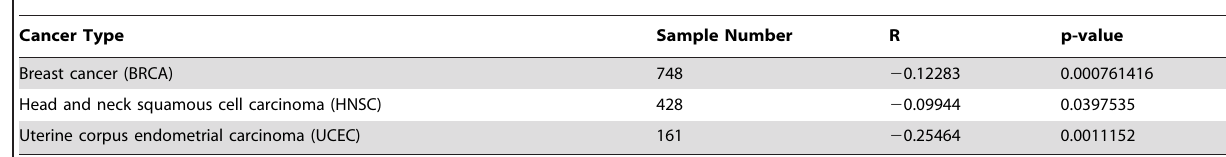
Table 3. Elk3:hsa-miR-155-5p Pearson correlations in cancer.